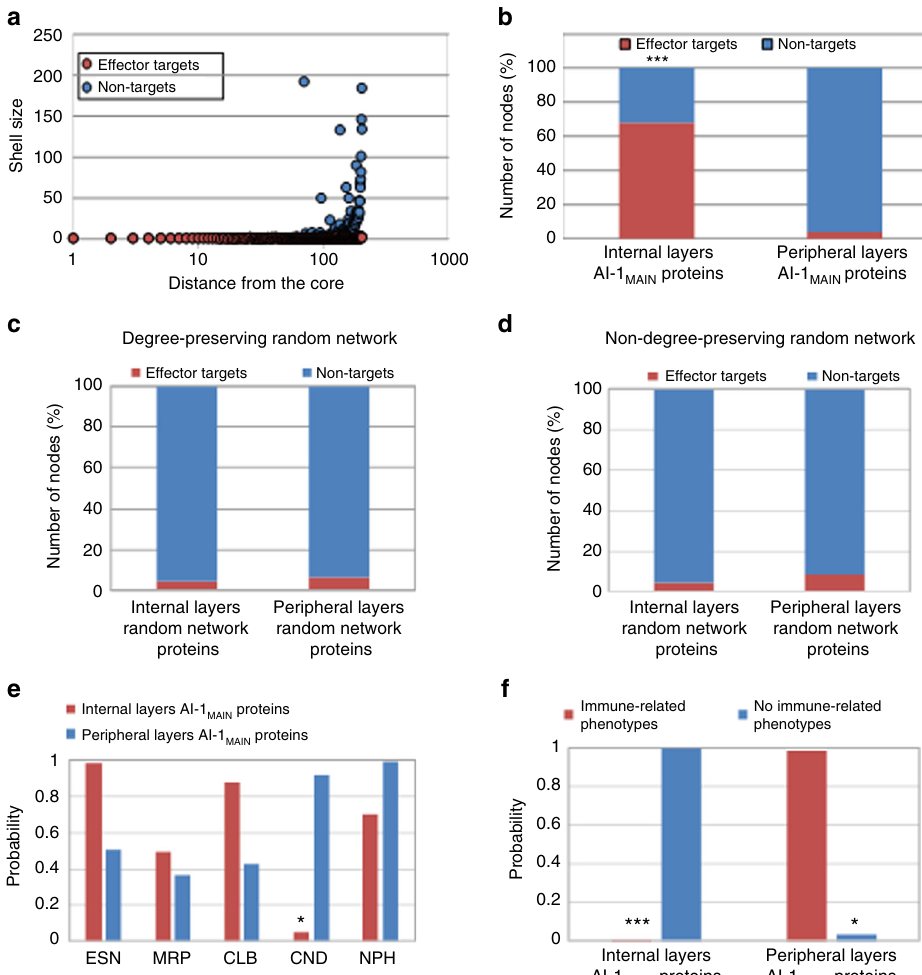
Fig. 3 Functional properties of effector targets. a Distribution of effector targets (red) and non-targets (blue) within shells of AI-1 MAIN encompassing varied sizes as well as locations with reference to the core indicated as 1. A shell index ranges from 1 to 1000 in logarithmic scale is demonstrated. b Percentage of effector targets (red) and non-targets (blue) in two categories of nodes, internal layers AI-1 MAIN proteins and peripheral layers AI-1 MAIN proteins, are displayed (hypergeometric P = 2.61 × 10 − 48 ). c , d Distribution of effector targets (red) and non-targets (blue) within shells of degree-preserving random network ( c ) and non-degree-preserving random network ( d ) are shown. e , f Phenotypic overrepresentation analyses among the nodes of effector targets (red) and non-targets (blue). Enrichment of CND (hypergeometric P = 0.05) and immune-related phenotypes (hypergeometric P = 2.55 × 10 − 6 ) in e and f , respectively for effector targets (red) are shown. Overrepresentation of no immune-related phenotypes in nodes located in peripheral layers are demonstrated (hypergeometric P =